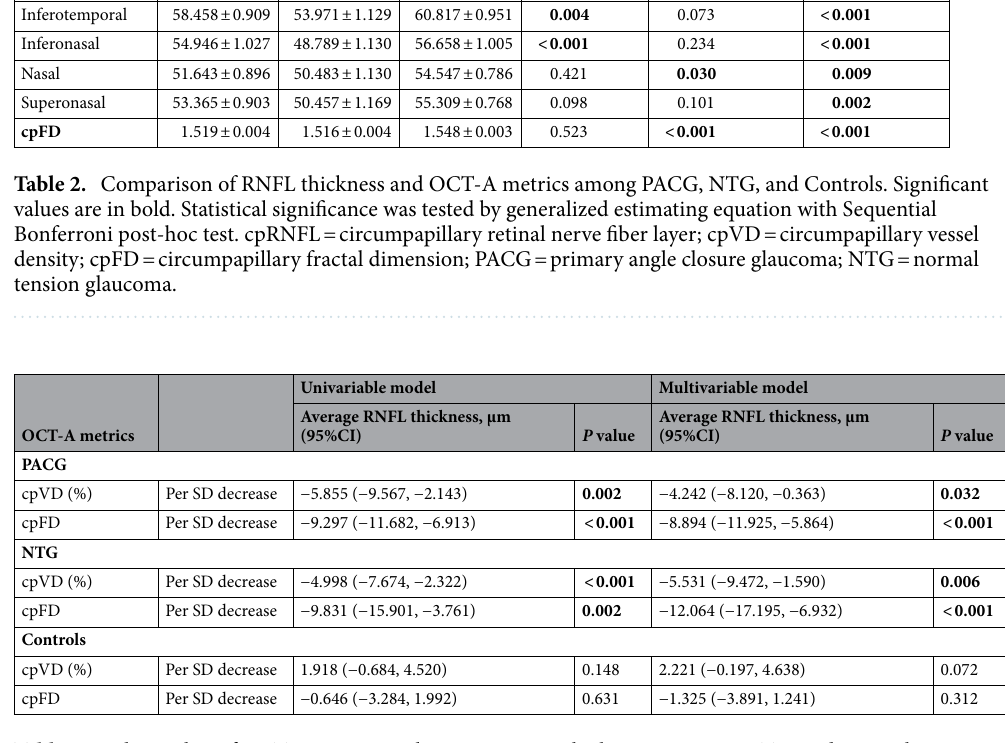
Table 3. Relationship of OCT-A metrics with average RNFL thickness in PACG, NTG, and Controls. Significant values are in bold. cpVD = circumpapillary vessel density; cpFD = circumpapillary fractal dimension; PACG = primary angle closure glaucoma; NTG = normal tension glaucoma; RNFL = retinal nerve fiber layer; CI = confidence interval; SD = standard deviation. Multivariable model adjusted for age, sex, spherical equivalent, intraocular pressure, number of glaucoma medications and OCT-A image quality score.